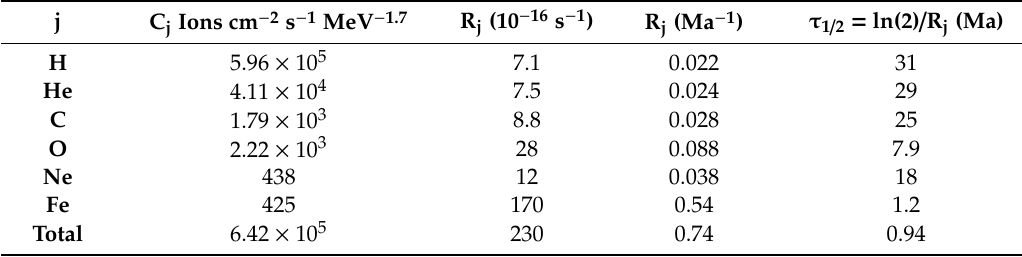
Figure 14. ( a ) Galactic cosmic ray (GCR) flux densities as predicted by Shen et al. [37]. ( b ) Valine destruction rate dependence on cosmic ray energy. Table 5. The C j flux parameter, the destruction rate R j (in second − 1 and in million-year − 1 ), and the half-live (in million-year) for each GCR species j.